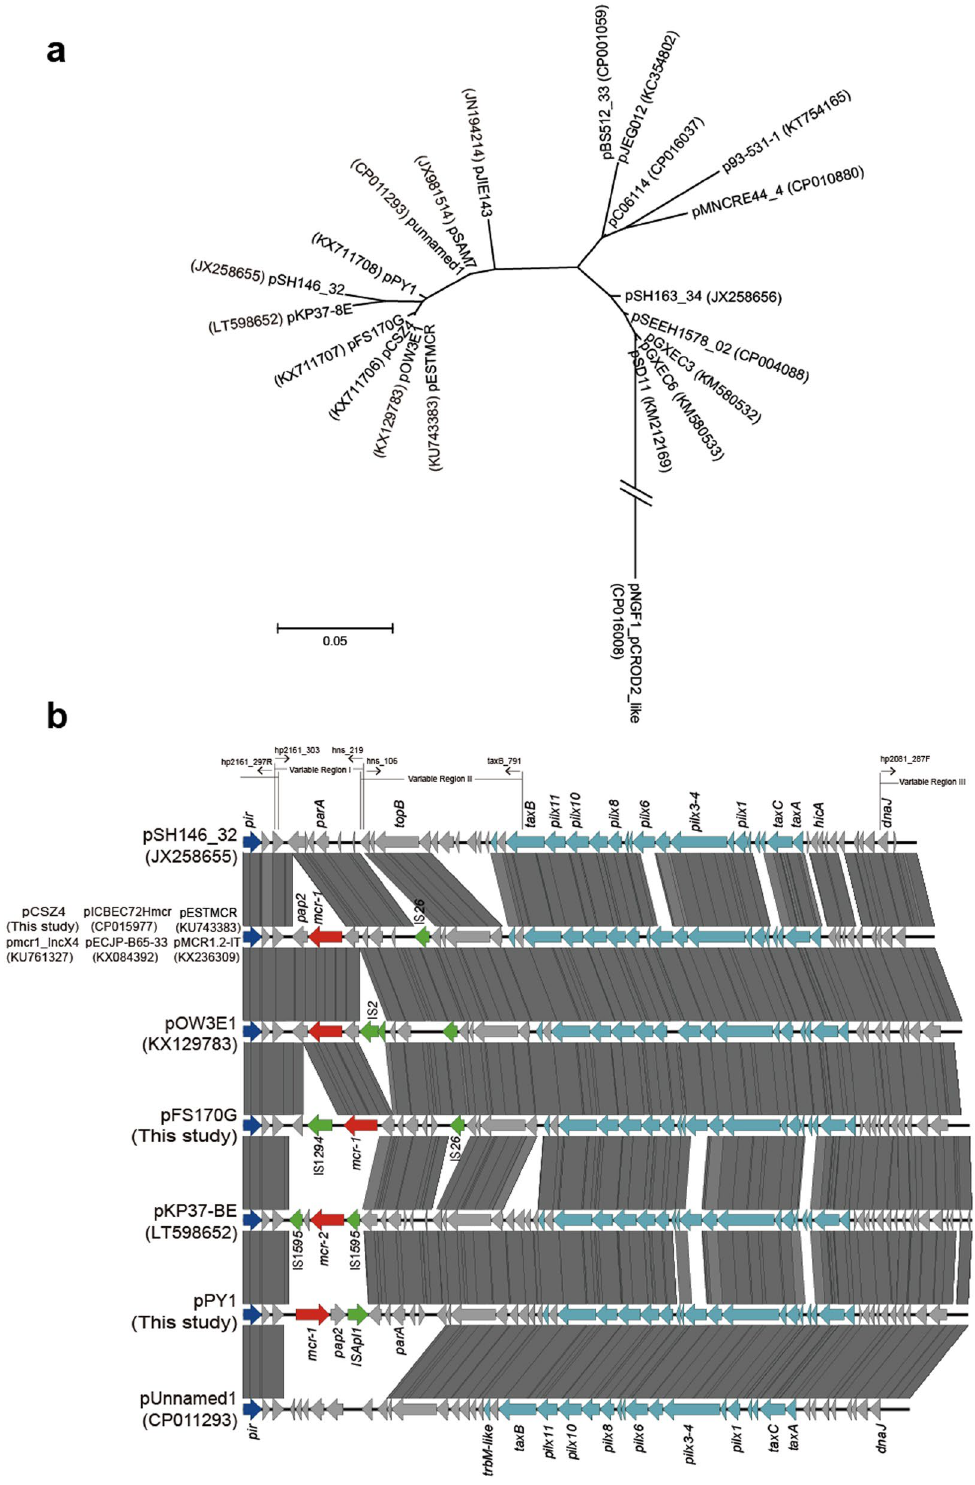
Figure 1. Phylogenetic tree and linear comparison of the 21 IncX4 plasmids. A total of 29 plasmids were collected by July 18, 2016, but only one was chosed for analysis in the highly similar plasmids. These plasmids included 3 found in this study and 18 downloaded from the GenBank (Table S1). ( a ) The trees are generated using MEGA (version 6) based on the complete sequence of IncX4 plasmids. ( b ) Boxed arrows represent the position and transcriptional direction of ORFs. Regions of > 99% identity are marked by grey shading. Genes associated with the tra and pil loci are colored light blue, replication associated genes are colored dark blue, antibiotic resistance genes are colored red, insertion sequences are colored green, and other genes are colored gray. The Variable Region I, II, and III, as well as the primers used were